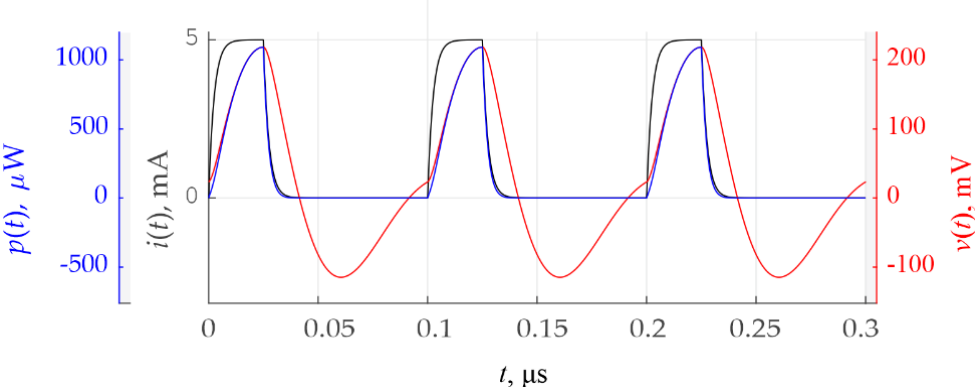
Figure 8. The current, voltage and power for the case of pulse train current.